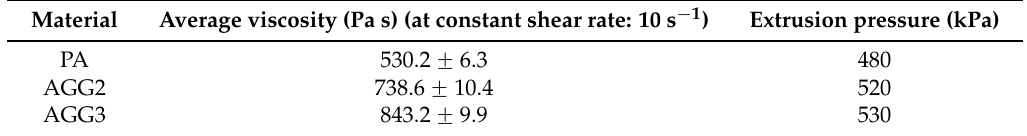
Figure 2. Light microscopic images of plotted scaffolds (25 layers) after freeze drying ( a – c ) (scale bar = 2 mm) and scanning electron microscopy (SEM) images of the scaffold surface ( d – f ; scale bar = 500 µm).